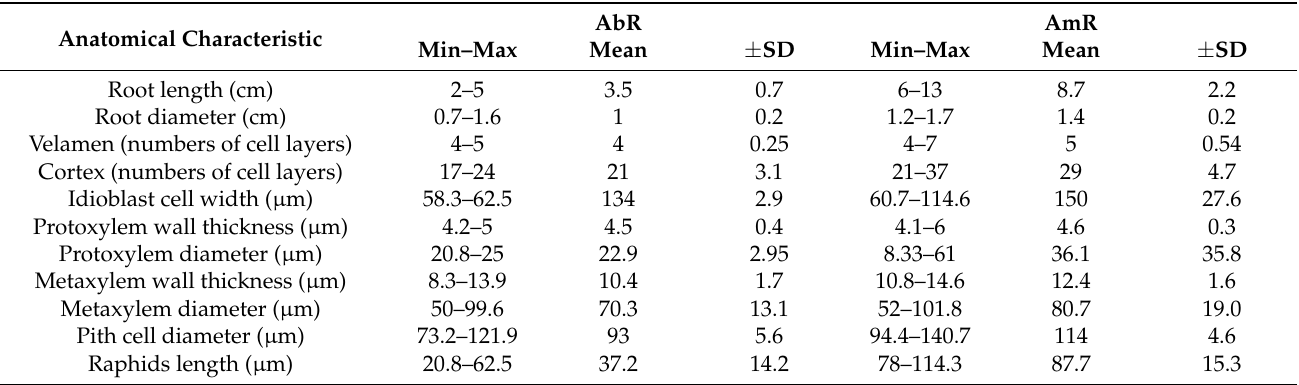
Table 1. Principal morphological and anatomical features of A. bento-rainhae and A. macrocarpus root tubers.